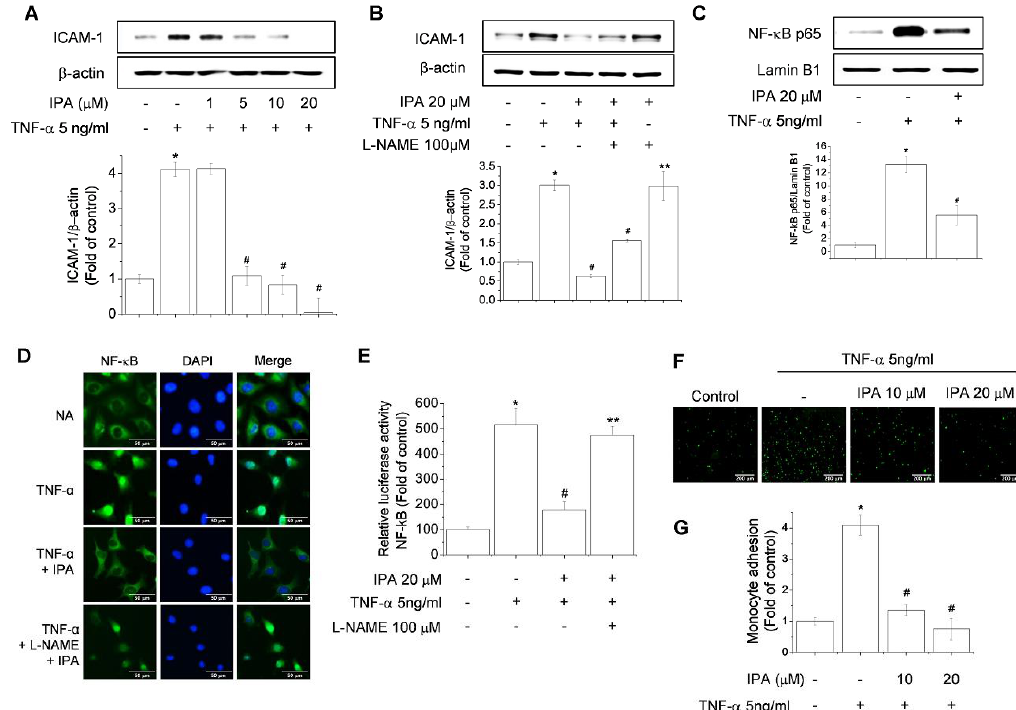
Figure 5. IPA treatment decreases the expression of adhesion molecules and inhibits the NF- κ B pathway. EA.hy926 cells were treated with di ff erent concentrations of IPA (1, 5, 10, and 20 µ M) for 1 h, followed by incubation with 5 ng / mL TNF- α for 24 h ( A ). Cells were pretreated with 100 µ M of the NOS inhibitor L-NAME for 1 h, and then treated with 20 µ M IPA for an additional hour, followed by incubation with 5 ng / mL TNF- α for 24 h ( B ). Cells were treated with 20 µ M for 1 h, followed by incubation with 5 ng / mL TNF- α for 6 h ( C ). Cell lysates were analyzed by western blotting using specific antibodies. The inhibitory e ff ect of IPA on TNF- α -induced NF- κ B activation blocked by L-NAME was assessed by reporter assay and immunofluorescence ( D , E ). EA.hy926 cells were pretreated with 10 or 20 µ M IPA for 1 h and TNF- α was added at 5 ng / mL for an additional 6 h. EA.hy926 cells were co-cultured with U937 monocytes for 1 h, and the adherence of endothelial cells to monocytes was assessed by fluorescence microscopy ( F , G ). Data are means ± SD of three independent experiments. * p < 0.05 compared with control. # p < 0.05 compared with IPA treatment. ** p < 0.05 compared with IPA and TNF- α treatment.